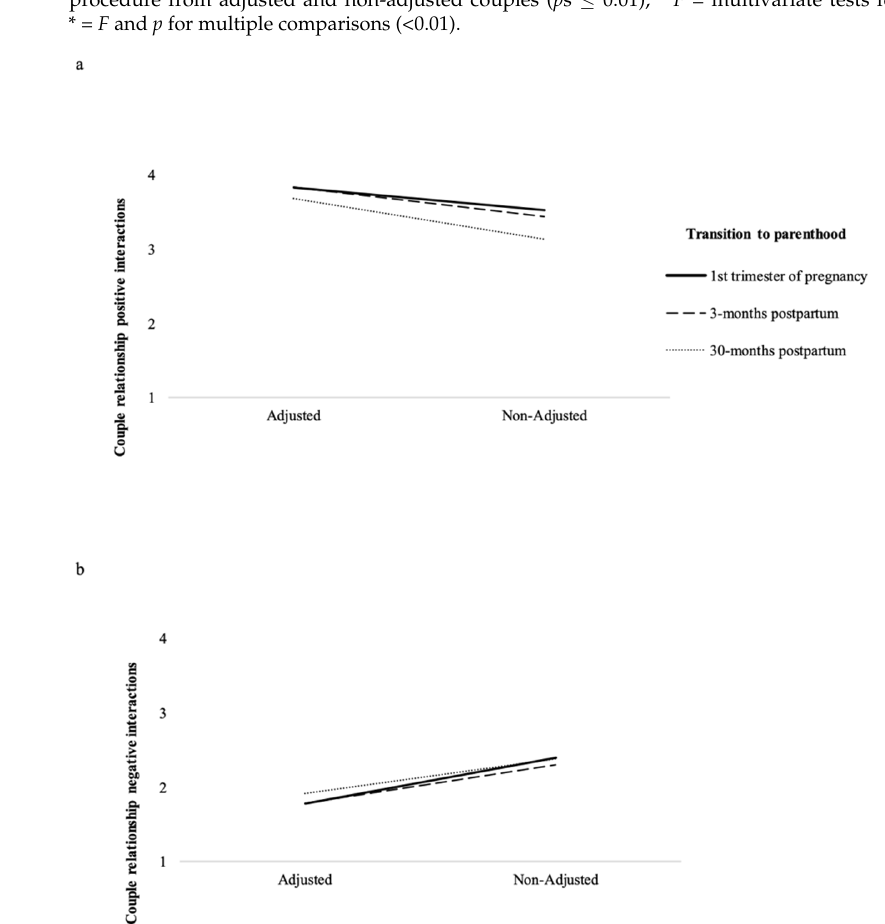
Figure 1. Significant interactions of time x clusters for ( a ) positive dimension of the couple’s relationship and ( b ) negative dimension of the couple’s relationship. Table 4. Means and standard deviations for clusters’ validation.